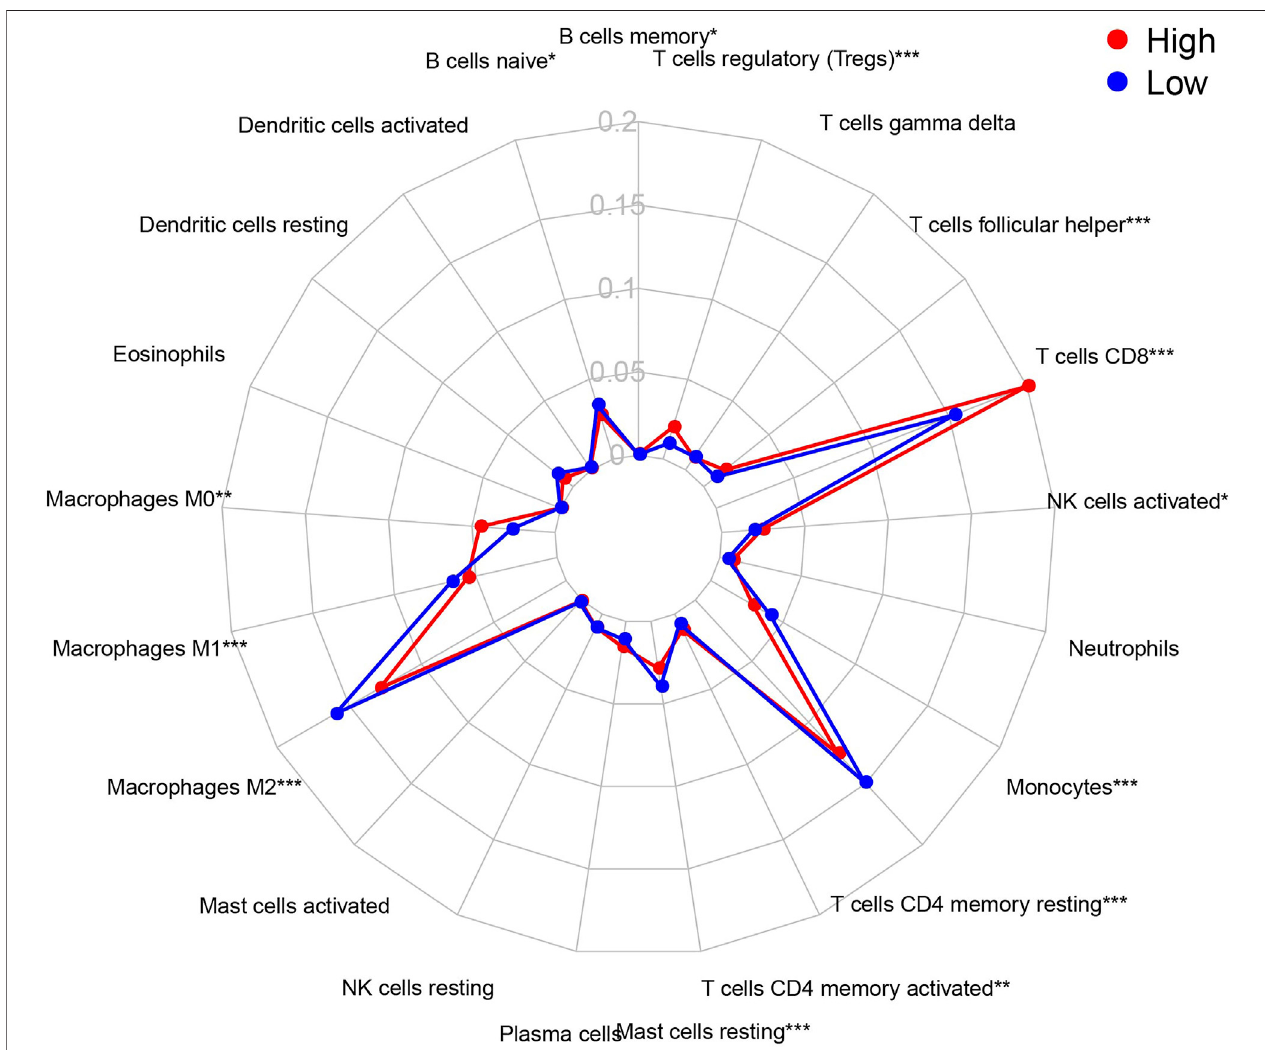
FIGURE 9 | Summary of the 21 immune cells ’ abundance for different risk groups of training cohort.